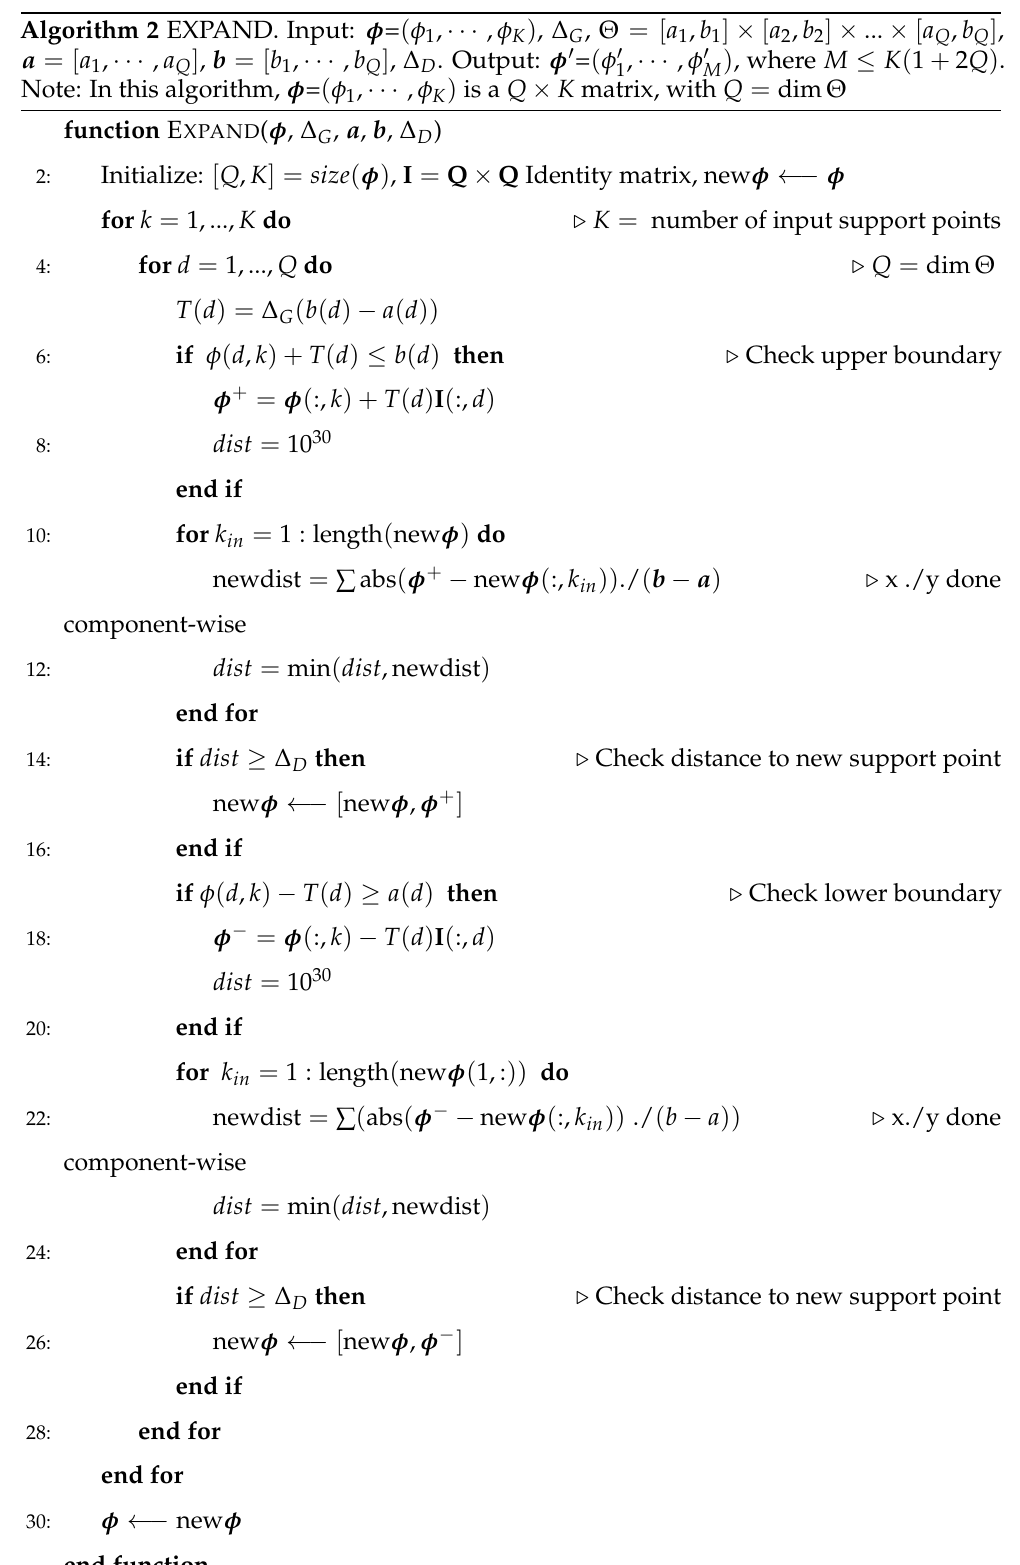
Algorithm 2 EXPAND. Input: φ = ( φ 1 , · · · , φ K ) , ∆ G , Θ = [ a 1 , b 1 ] × [ a 2 , b 2 ] × ... × [ a Q , b Q ]